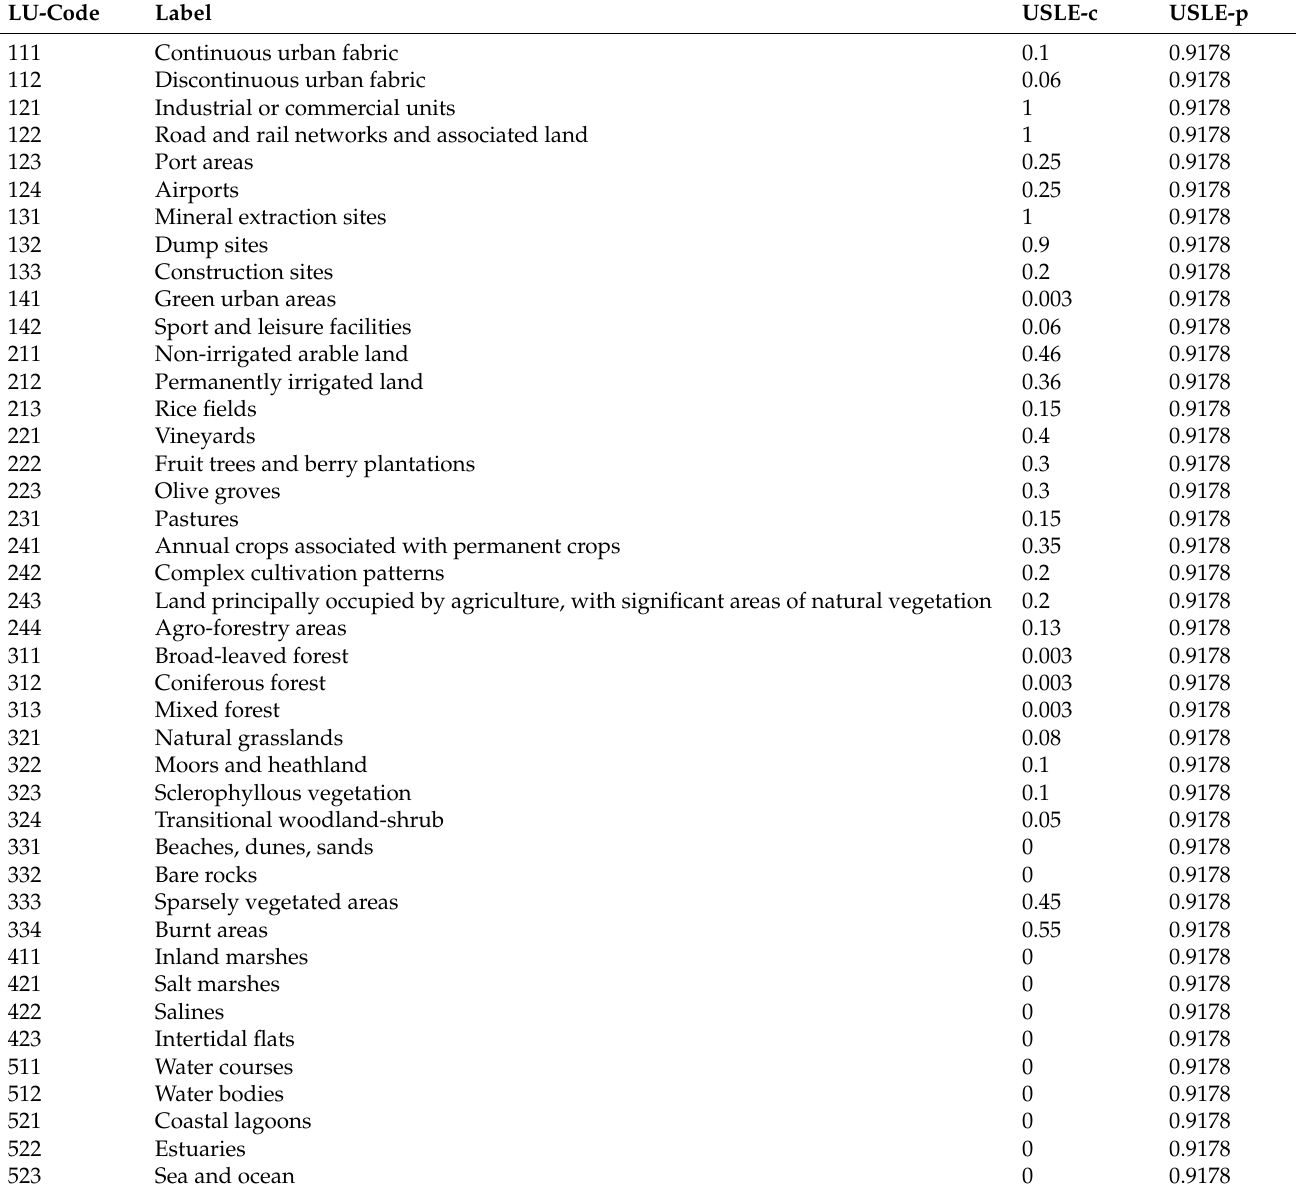
Table 2. The biophysical table used in the SDR model, where ”LU-code” is the CORINE Land Cover (CLC) code for each land use class, “label” is the description of the class, and Universal Soil Loss Equation-c (“USLE-c”) and “USLE-p” are the cover-management (C)) and support practices (P) factors, respectively.